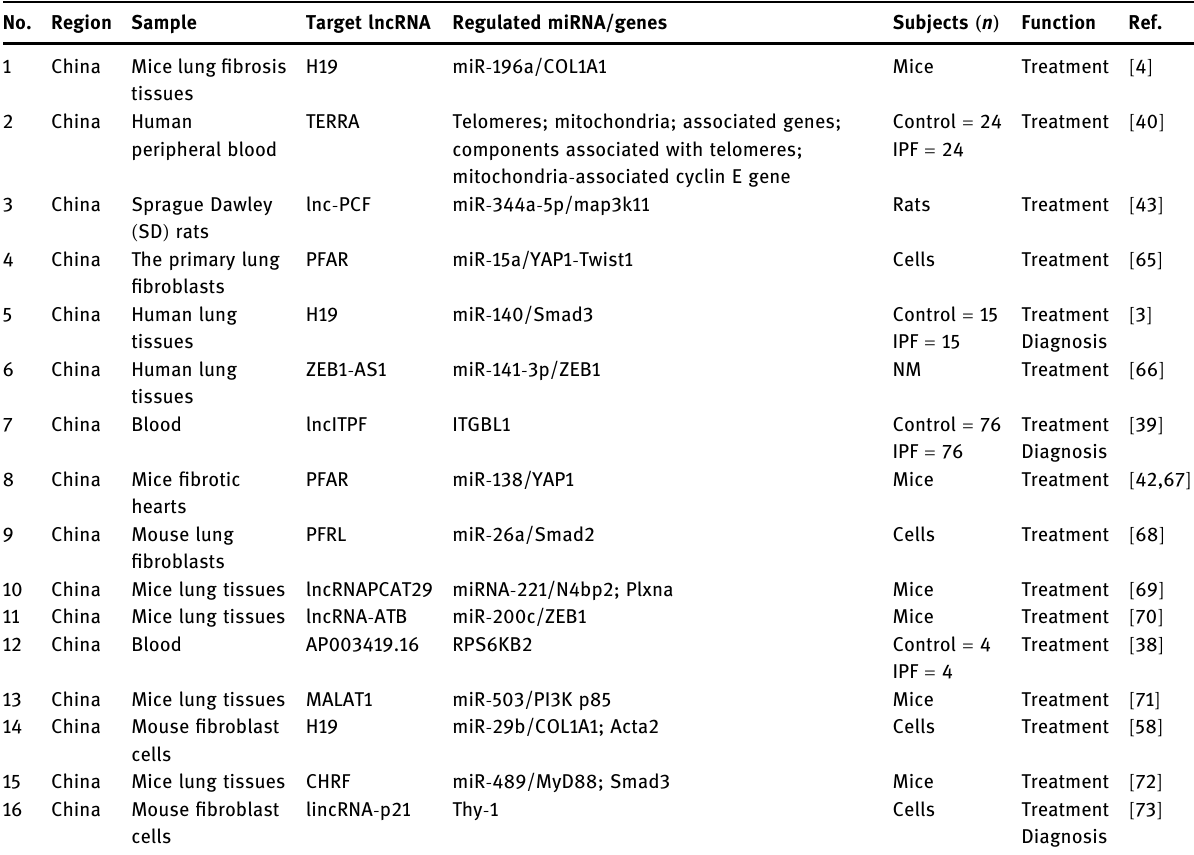
Table 2: Di ff erential expression of lncRNA in IPF No. Region